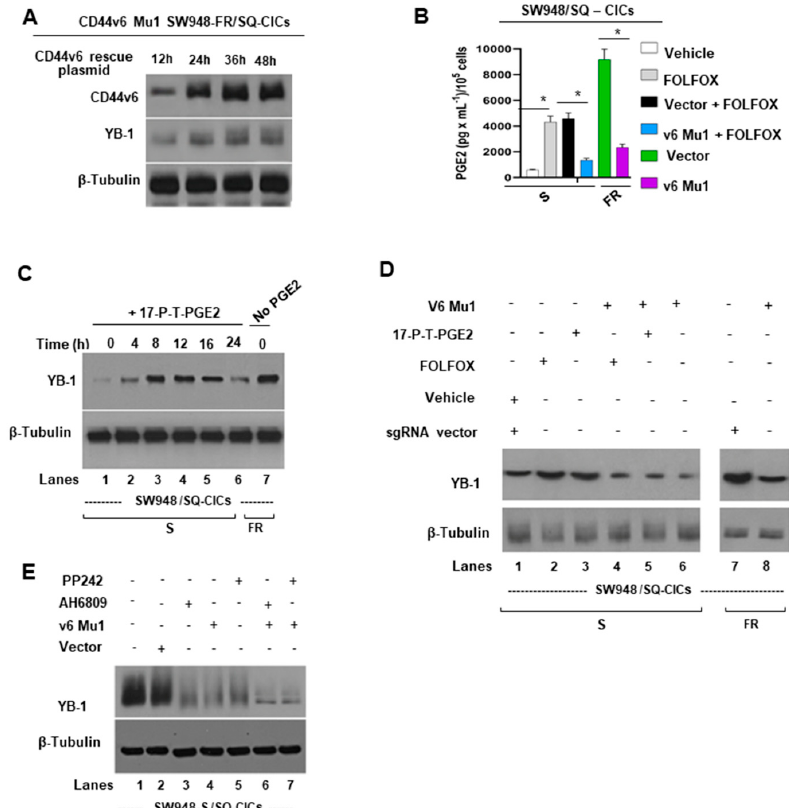
Figure 3. Mechanism of CD44v6 induced YB-1 expression. ( A ) Time course results are shown of CD44v6 and YB-1 protein expressions after transfecting the v6 rescue plasmid (described in the Methods section) into v6 Mu1 SW948-FR CICs. Expression of proteins at 0 h was not shown because of the absence of CD44v6 in the protein lysate. ( B ) Effects of knocking out CD44v6 in in v6 Mu1 CICs of sensitive and resistant SW948 cells on PGE2 production (analyzed by ELISA as described in Methods) in the presence and absence of FOLFOX treatment are shown. ( C ) 17-P-T-PGE 2 (synthetic PGE2) induces YB-1 in CICs that were treated with PGE 2 at 5 µM for the indicated times. YB-1 expression levels were determined by immunoblotting with anti-YB-1 antibody; β -tubulin as loading control. ( D ) Effects are shown of CD44v6 Mu1 knockout on PGE2 and FOLFOX induced YB-1 expression. CICs isolated from SW948-S and SW948-FR that were previously transfected with either v6 Mu1 or vector for 48 h and then treated with or without synthetic PGE2 or FOLFOX. YB-1 expression levels were determined by immunoblotting with anti-YB-1 antibody; β -tubulin as loading control. ( E ) Effects are shown of PGE 2/EP1 receptor, and of mTOR signaling on Y B-1 expression. CICs were either transfected with in v6 Mu1 or vector for 48 h and then treated with or without EP1 inhibitor (5 µM AH6809) or mTOR inhibitor (10 nM PP242) for 2 h. They were then cultured in serum-free medium for 16 h and treated with synthetic PGE2 at 5 µM, or 1 × FOLFOX for 24 h. The cell lysates were processed for YB-1 and β -tubulin (as loading control). PGE2 secretion data in Figure 3B represent means ± SD; n = 4–6; * p < 0.05 compared to either vehicle control, vector + FOLFOX treatment group, or vector control group.